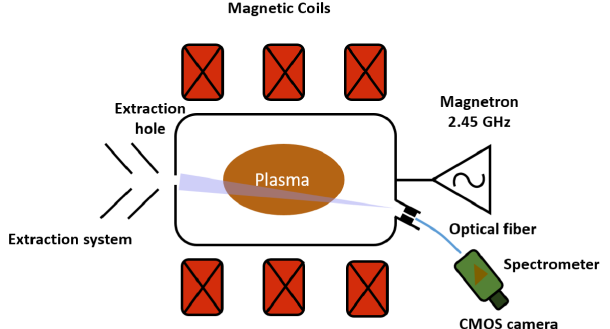
FIG. 2. Schematic of the PS-ESS experimental setup at the